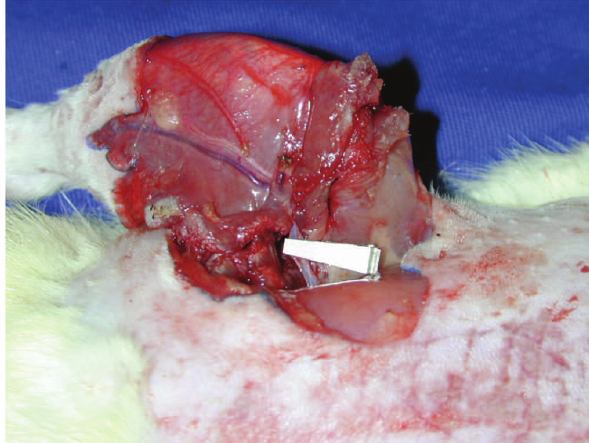
Figure 2 - Limb undergoing replantation and positioning of the microvascular